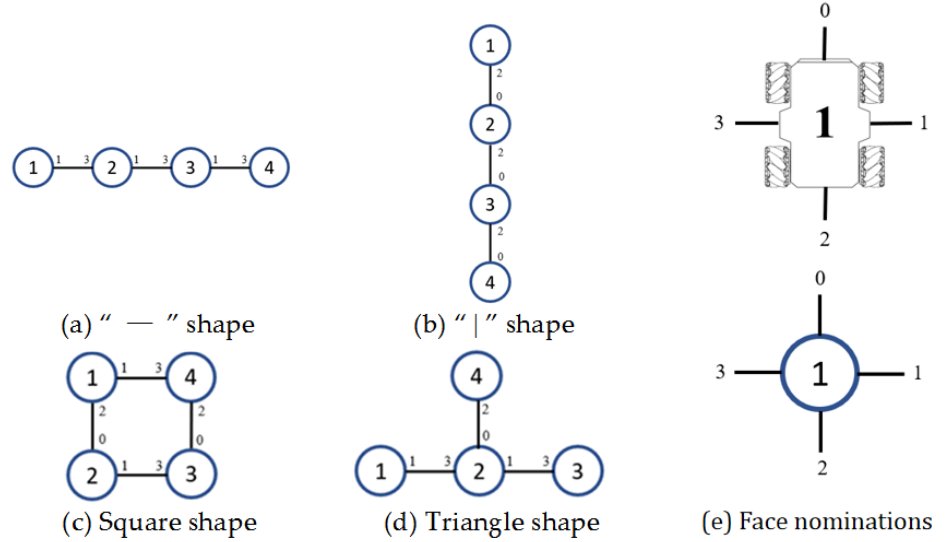
Figure 9. Force analysis of improved artificial potential field method .